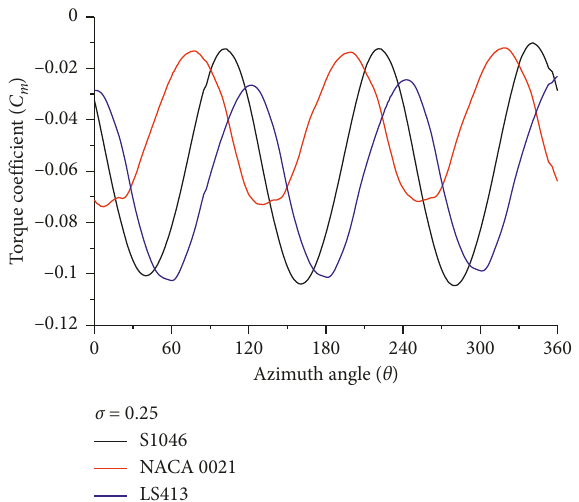
Figure 10: Instantaneous dynamic torque coefficient on the Darrieus